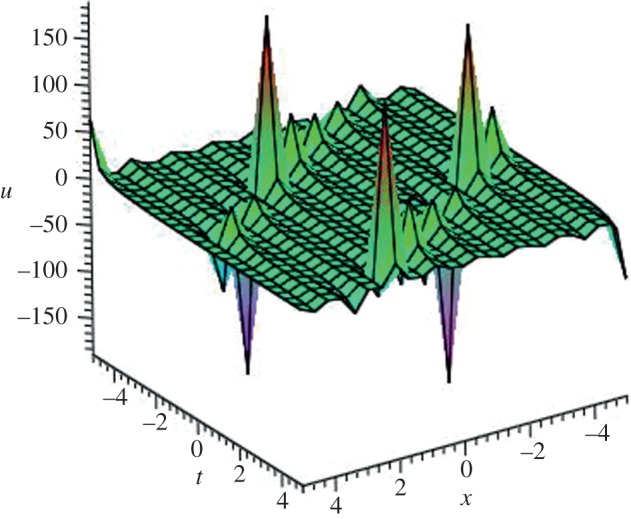
Periodic solution u29(ξ) of mBBM equation for a=1, b=1 and k=7.